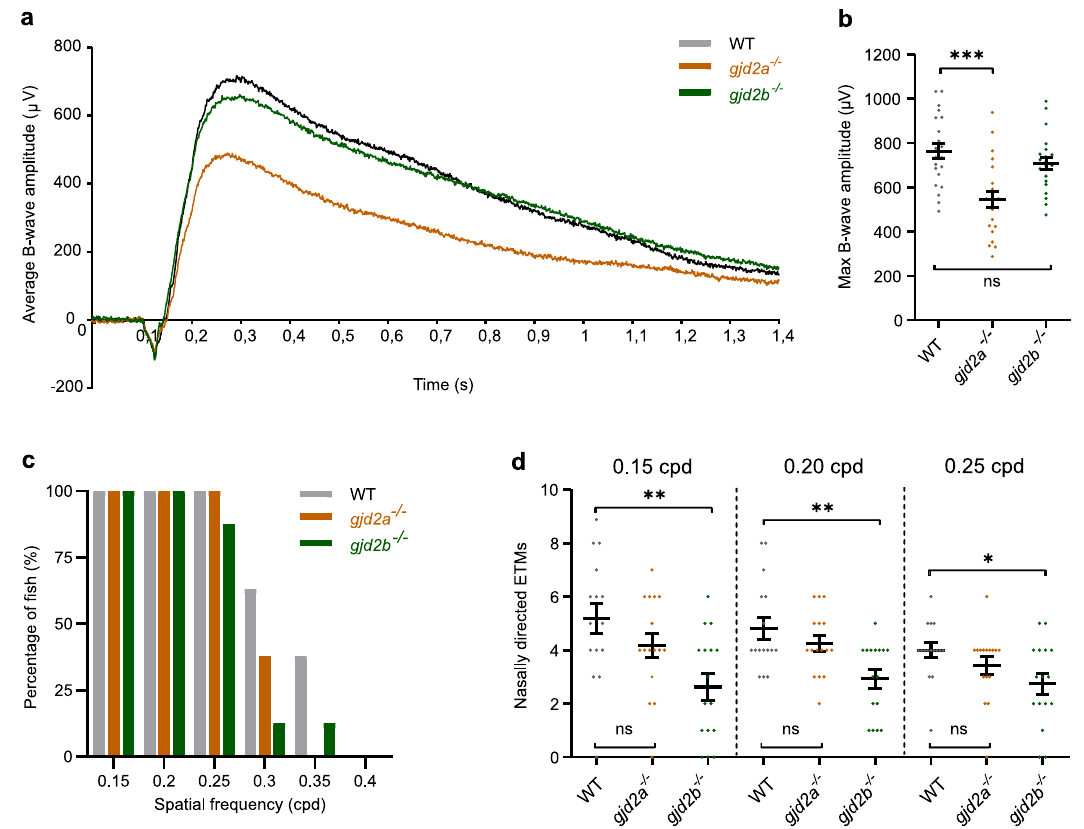
Fig. 5 B-wave potential and spatial acuity in gjd2a (Cx35.5) and gjd2b (Cx35.1) mutants. a Electroretinogram showing the average B-wave potential for eyes of gjd2a (Cx35.5) mutants, gjd2b (Cx35.1) mutants, and WT control fi sh at 2.5 mpf ( n = 22 fi sh). b Maximum B-wave amplitude response. c Spatial visual acuity indicated by the proportion of fi sh completing a minimum of three subsequent optokinetic responses at spatial frequencies ranging from 0.15 to 0.40 cpd. d Nasally directed ETMs per 10-s interval for spatial frequencies ranging from 0.15 to 0.25 cpd. Error bars: SEM. Signi fi cance: ns = not signi fi cant, * p < 0.05, ** p < 0.01, *** p < 0.001. ETM eye-tracking movements, cpd cycles per